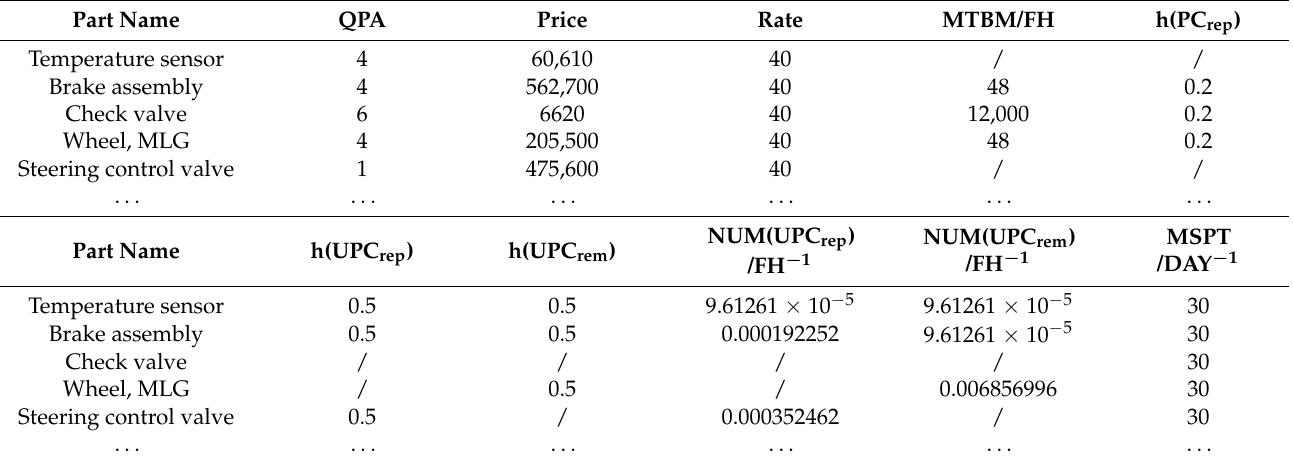
Table 1. Data preparation for